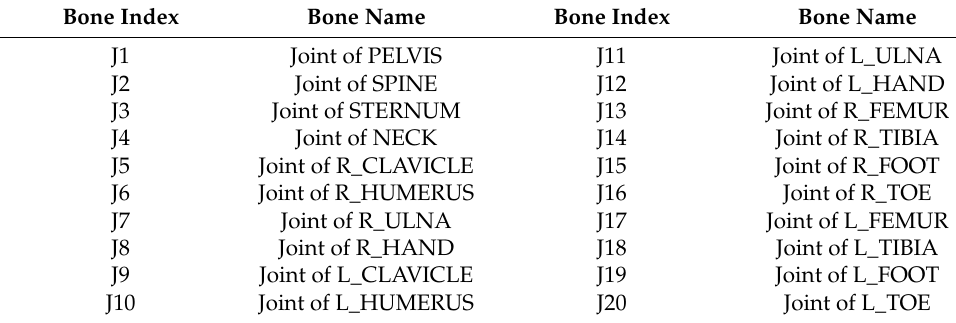
Table 5. List of joint names.